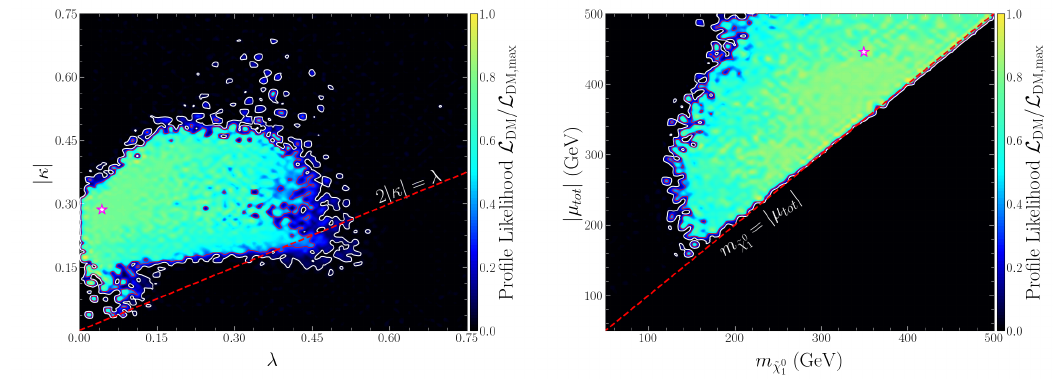
Figure 1 . Two-dimensional profile likelihood of function L DM in eq. (3.3) for h ≡ h 1 scenario, which is projected onto | κ | − λ and | µ planes of µ NMSSM. Since χ 2 ’ 0 for the best tot | − m ˜ χ 0 Best 1 point (marked with a star symbol in figure), the boundaries for 1 σ (red solid line) and 2 σ (white solid line) confidence intervals correspond to χ 2 ’ 2 . 3 and χ 2 ’ 6 . 18 , respectively. Dotted-dashed line represents relation 2 κ = λ . Points around m ’ | µ tot | on right-hand panel obtained correct ˜ χ 0 1 abundance by co-annihilation. This figure shows µ NMSSM’s parameter region that can well explain DM experiments.